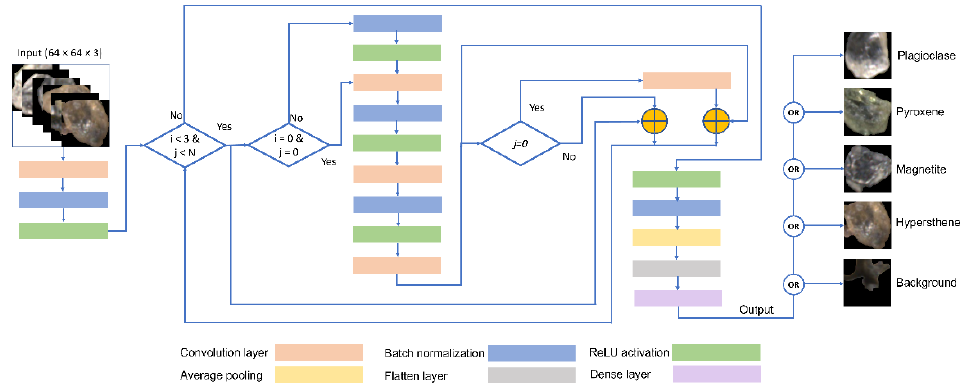
Figure 10. ResNet version 2 architecture for mineral recognition.